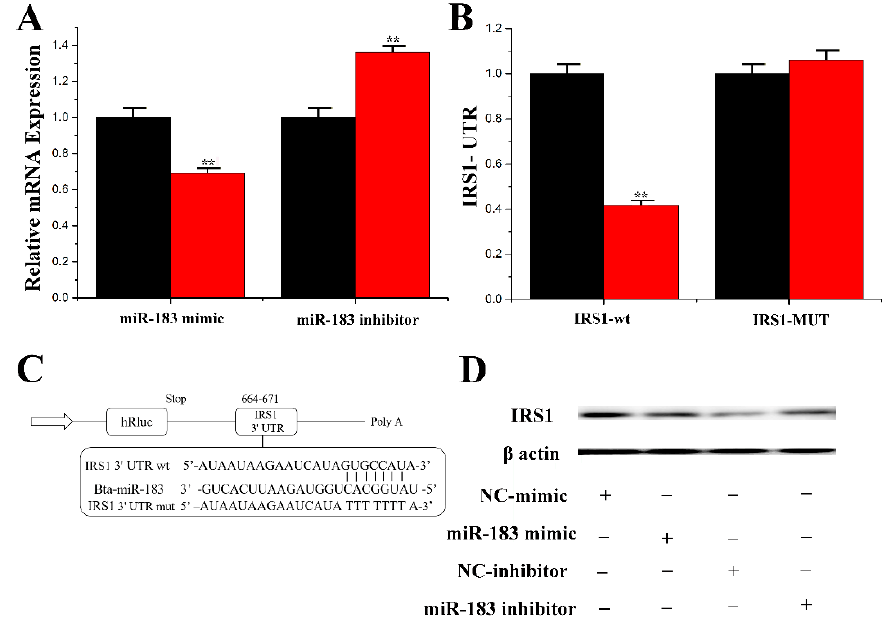
Figure 5. miR-183 specifically targets IRS1. ( A ) RT-qPCR quantification of the IRS1 expression (n = 6). Red bars represent the negative control; black bars represent miR-183 mimic or inhibitor; ( B , C ) Target site of miR-183 in IRS1 3 ′ -UTR and the construction of the luciferase (Luc) expression vector fused with the IRS1 3 ′ -UTR. WT represents the Luc reporter vector with the WT IRS1 3 ′ -UTR (664-671); MU represents the Luc reporter vector with the mutation at the miR-183 site in IRS1 3 ′ -UTR; ( D ) The effect of miR-183 mimicking and inhibiting IRS1 protein expression was evaluated by Western blot analysis in CMECs. All experiments were duplicated and repeated three times. Values are presented as means ± standard deviation, ** p < 0.01.